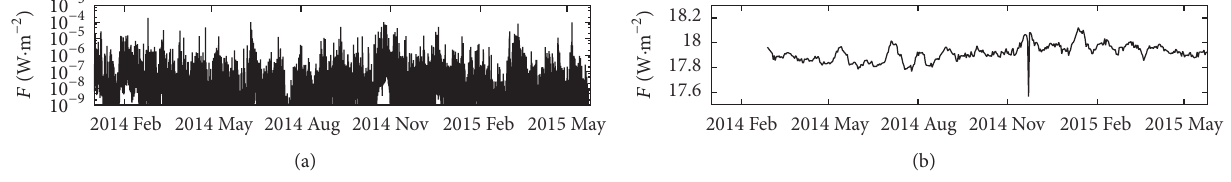
Figure 3: Solar X-ray observations by GOES-15 satellite in 0.5 ˚A–4 ˚A spectral range (3–25 keV) in (a) and near UV observations by SORCE satellite in spectral range 231–309 nm in (b) during the period from January 2014 to May